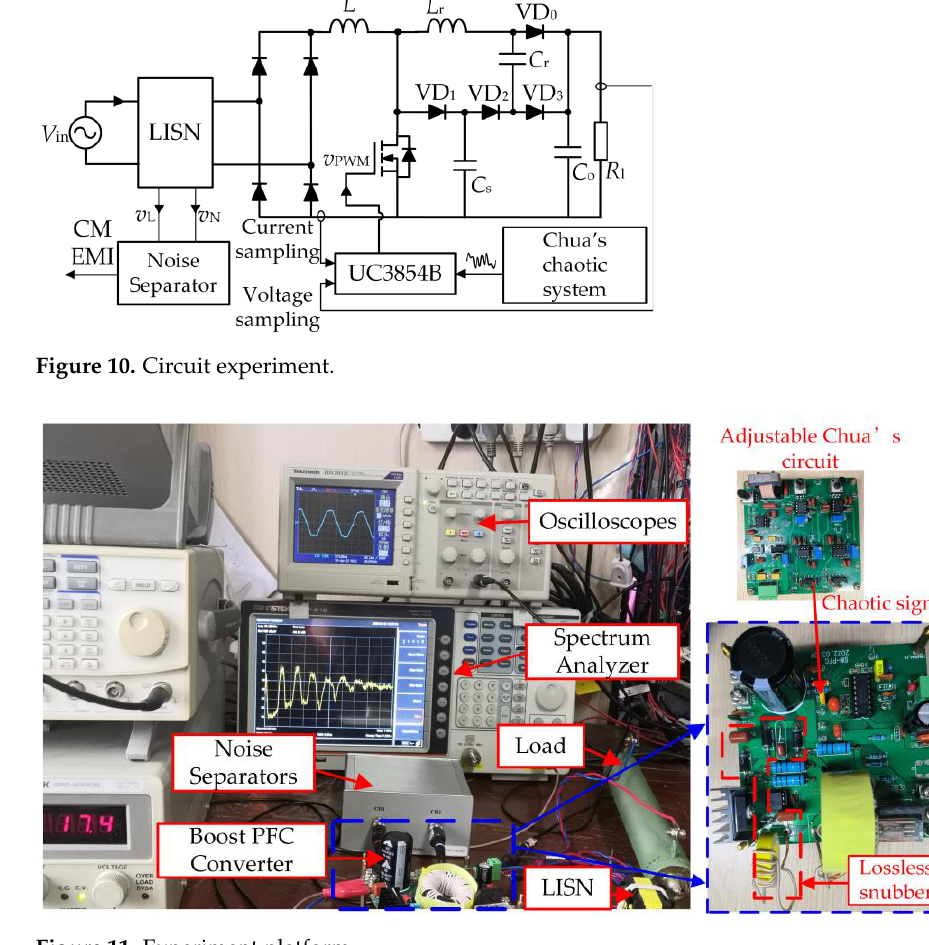
Figure 12. Chaotic spread spectrum: ( a ) Chaotic attractor and ( b ) Sawtooth waveform. Figure 13. CM EMI spectrum.